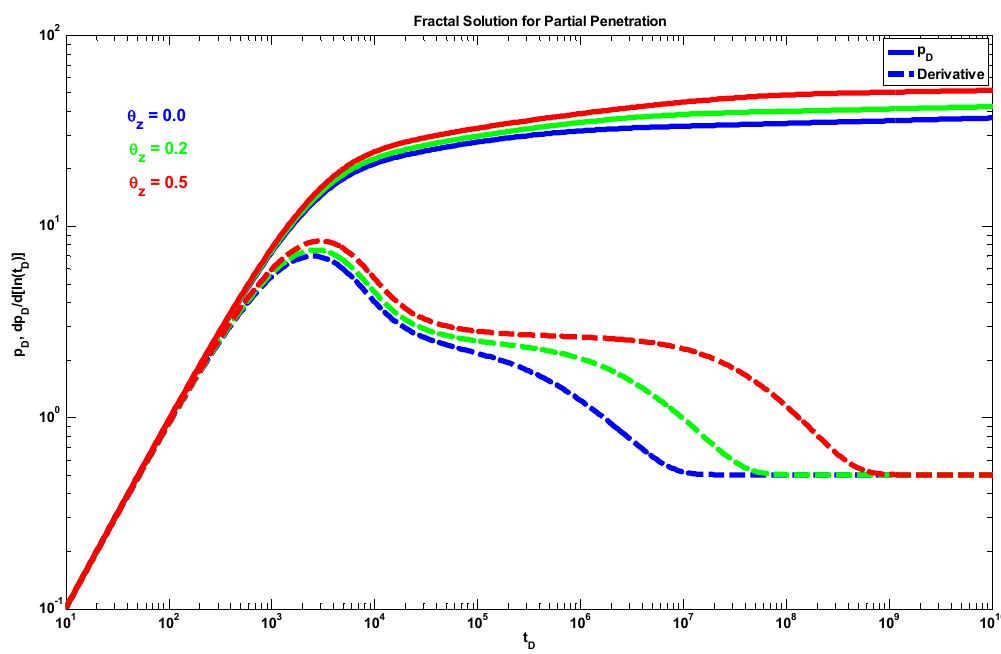
Figure 9. Fractal case: z wD = 0.4, h D = 10,000, h pD = 0.2, S = 0, C D = 100, ε = 1, d fr = 2.0, θ r = 0, d fz = 1.0 .